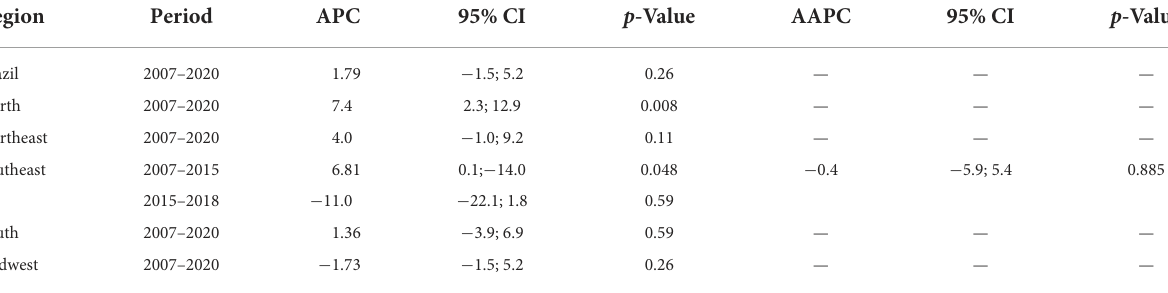
TABLE 2 Temporal trend analysis of annual aged-adjusted HIV/AIDS population-level incidence rates in Brazilian WSMW, 2007–2020. Region Period APC Brazil